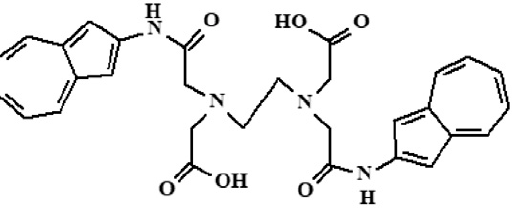
Figure 1. The structure of (2,2 ′ -(ethane-1,2-diylbis((2-(azulen-2-ylamino)-2-oxoethyl)azanediyl))diacetic acid, ( L ) .